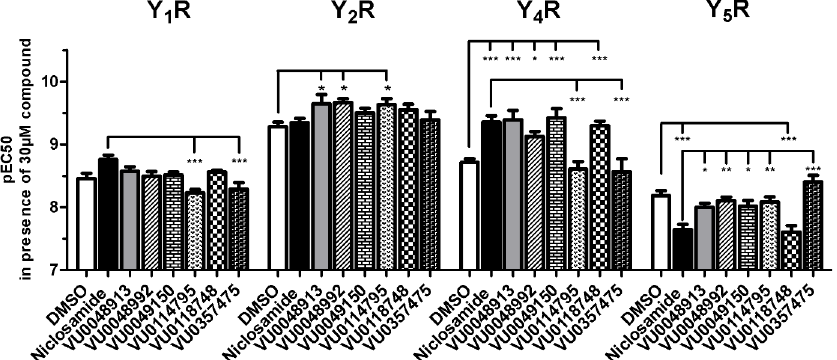
Fig 4. YR subtype selectivity of Y 4 R PAMs. Effect of 30 μ M compound on the pEC 50 of Y-receptor agonists in COS-7 cells stable expressing a Y receptor subtype and the chimeric G-protein G α 6qi4myr . Receptors were stimulated with their native ligands (Y 1 R, Y 2 R, Y 5 R: NPY; Y 4 R: PP). For Y-axis values, positive modulation represents an increase in the apparent potency (pEC 50 ) of the native agonist and negative modulation represents a decrease in the apparent potency of the native agonist. Data represent the mean ± SEM of at least two independent experiments (for full concentration-response curves see S2 Fig) ( * p < .05, *** p < .001 Bonferroni).